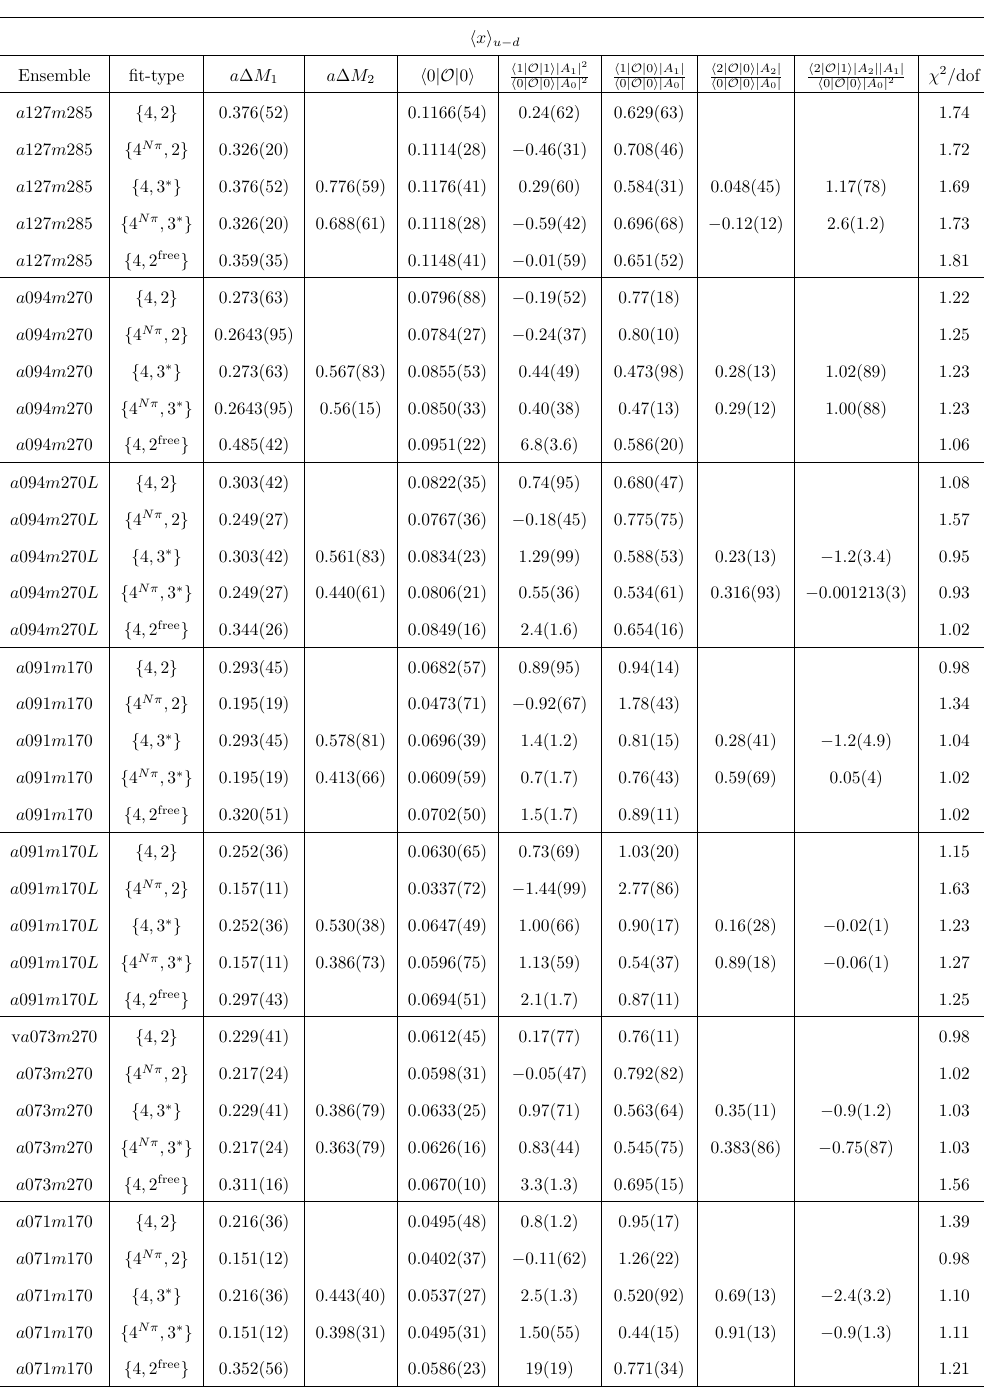
Table 7 . Comparison of results of the fits to remove the excited-state contamination for the mo- The fit parameters, defined in eq. (5.2), are given for all seven ensembles along with the χ 2 / dof of the